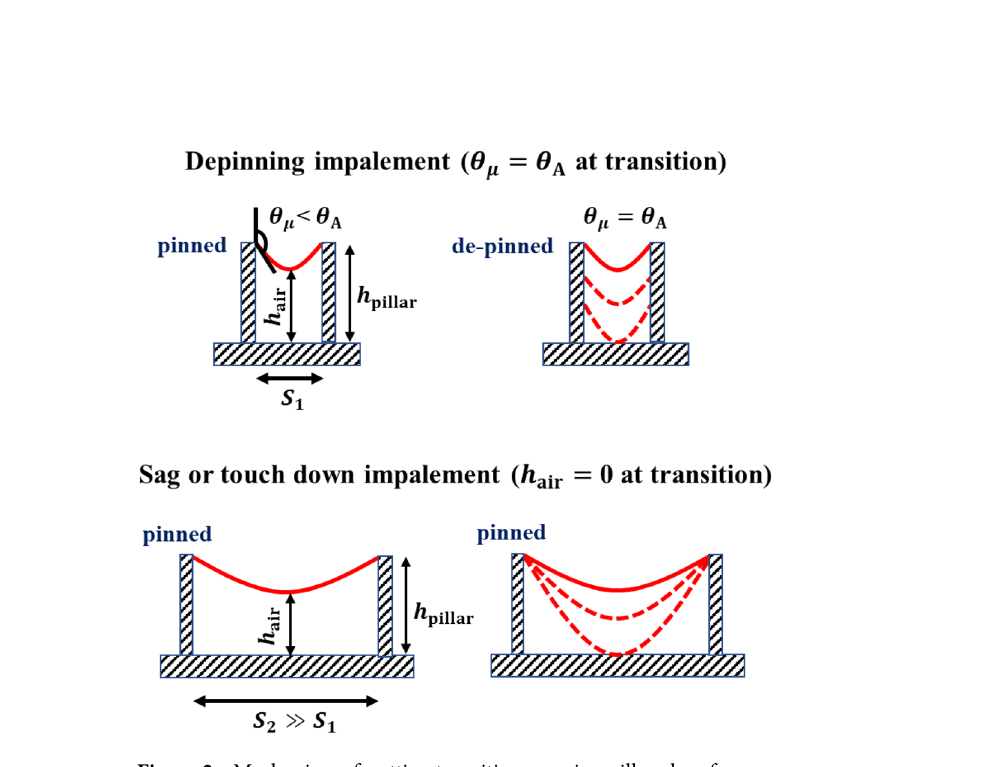
Figure 2. Mechanism of wetting transition on micropillared